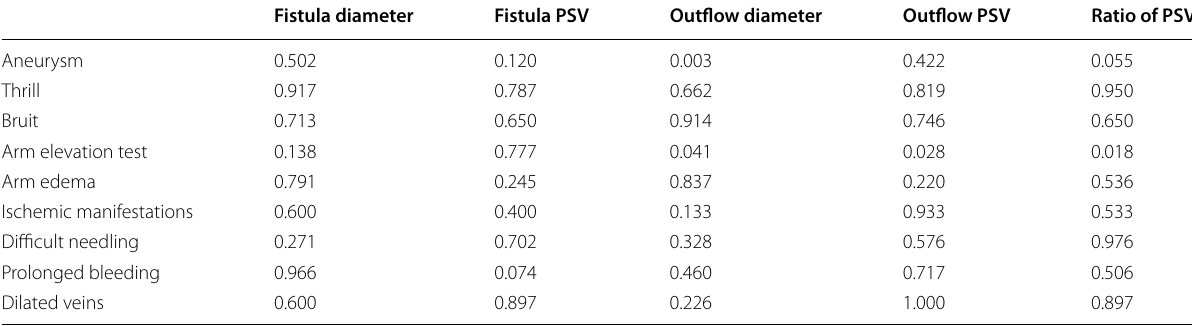
Table 5 Association between the clinical examination results and CDU measurements